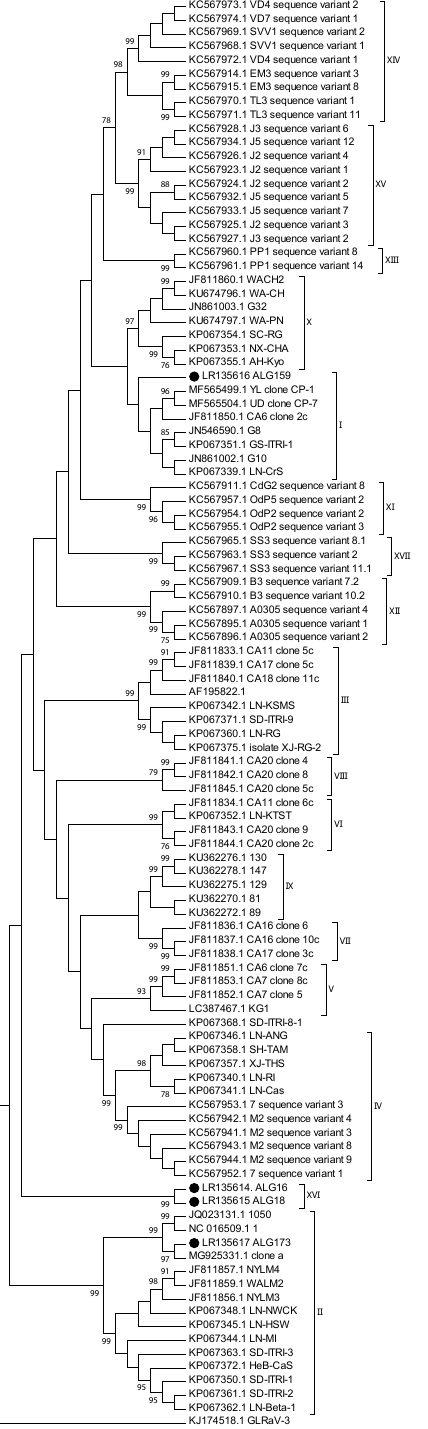
Figure 1. Phylogenetic tree of Grapevine leafroll associated virus 1 (GLRaV-1) isolates, constructed with sequences of a 585 nt frag- ment of the viral coat protein gene. Percentages of bootstrap sup- port (≥ 75%) from 1,000 replicates are indicated on relevant tree branches.